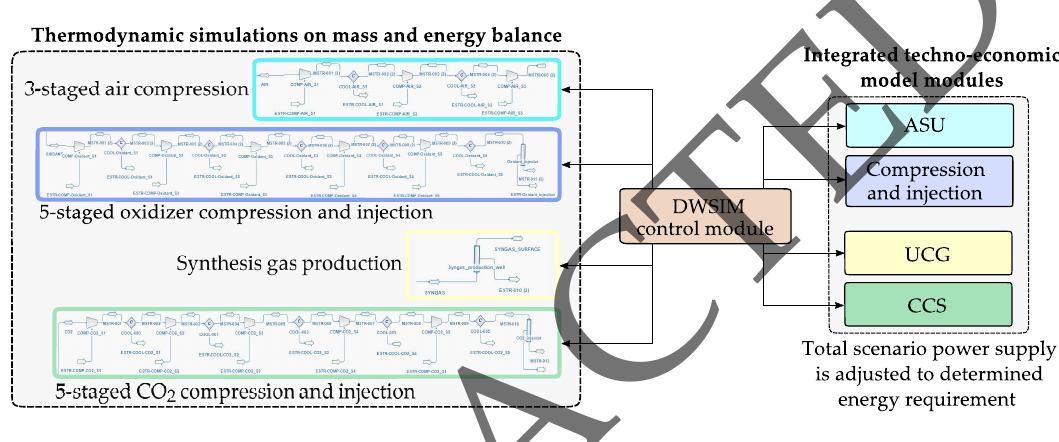
Figure 5. Integration of techno-economic model with thermodynamic process simulations by means of the DWSIM process simulator [21], considering air compression, oxidizer compression and injection, synthesis gas production as well as CO 2 compression and